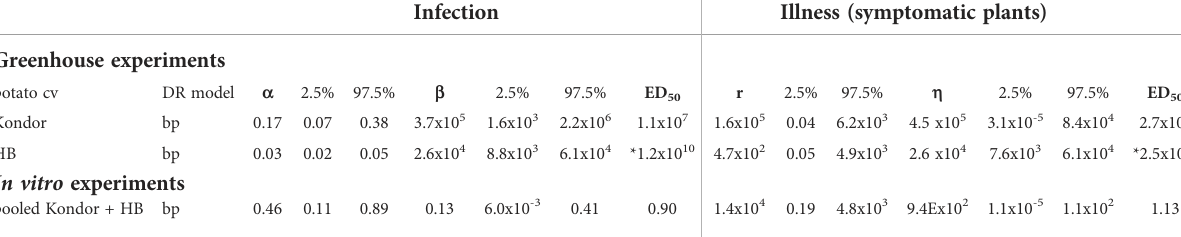
TABLE 3 Estimated parameters of dose-response models for infection and illness and respective values of the 95% con fi dence interval. Infection Illness (symptomatic